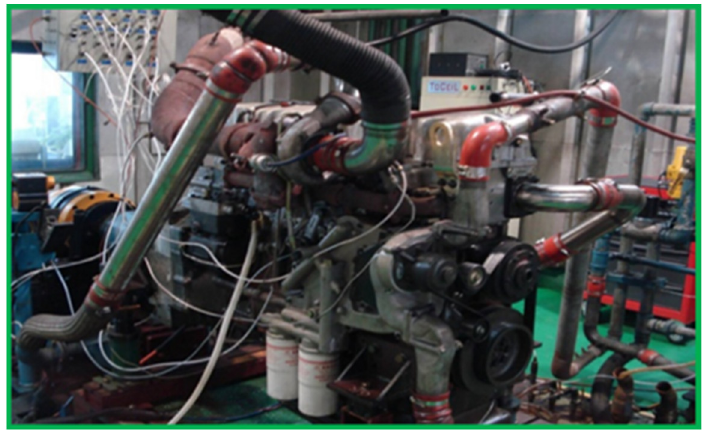
Figure 1. The YC6K test diesel. Table 1. The technical specifications of the test engine.